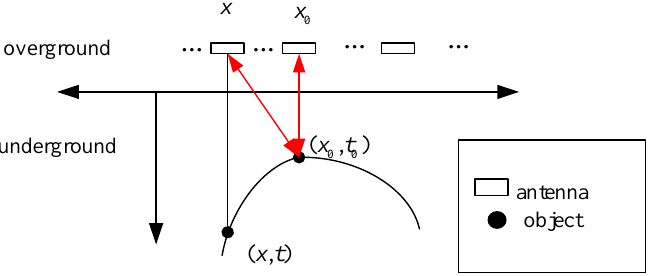
Figure 1. A simple reflection model for GPR. The antenna position x and the echo time delay t approximately satisfy the hyperbolic Equation (1).